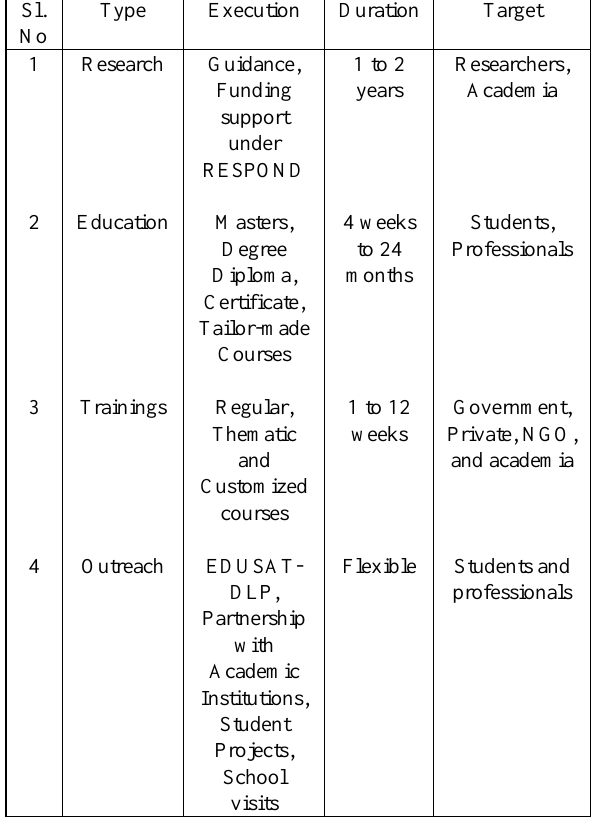
Table 1. ISRO Capacity building (Senthil Kumar, 2016)